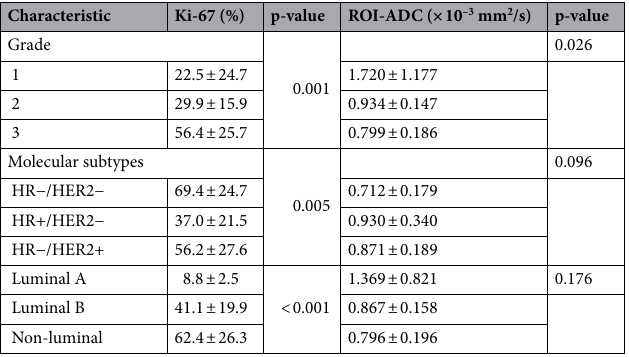
Table 1. Baseline tumor characteristics of the study population. HER2 human epidermal growth factor receptor 2, HR hormone receptor, Ki-67 Ki-67 proliferation index, ROI region of interest, ADC apparent diffusion coefficient.